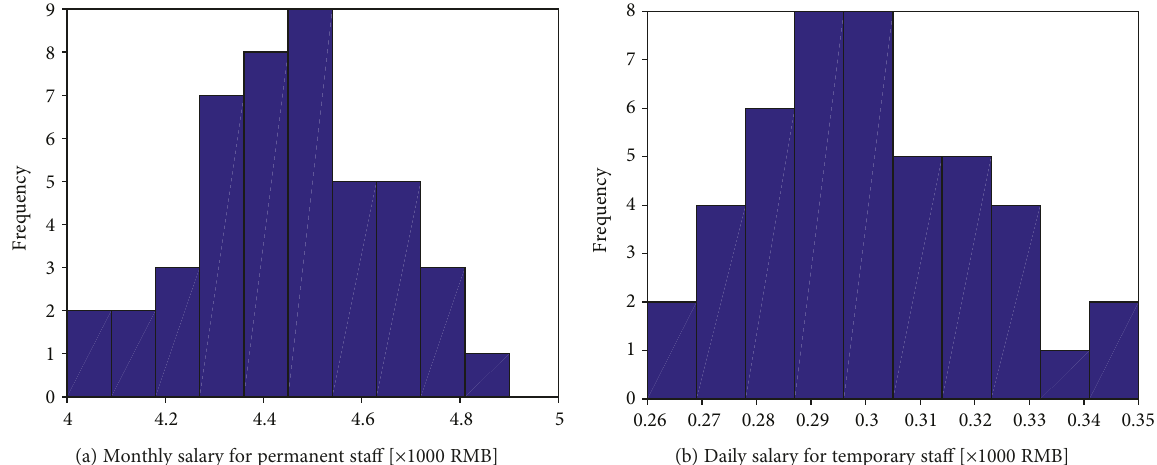
Figure 7: Histogram for the price